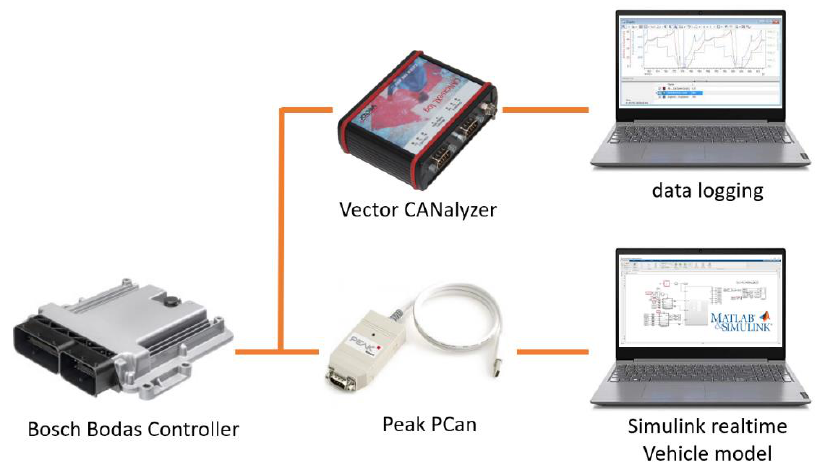
Figure 5. Architecture of the SiL test bench.